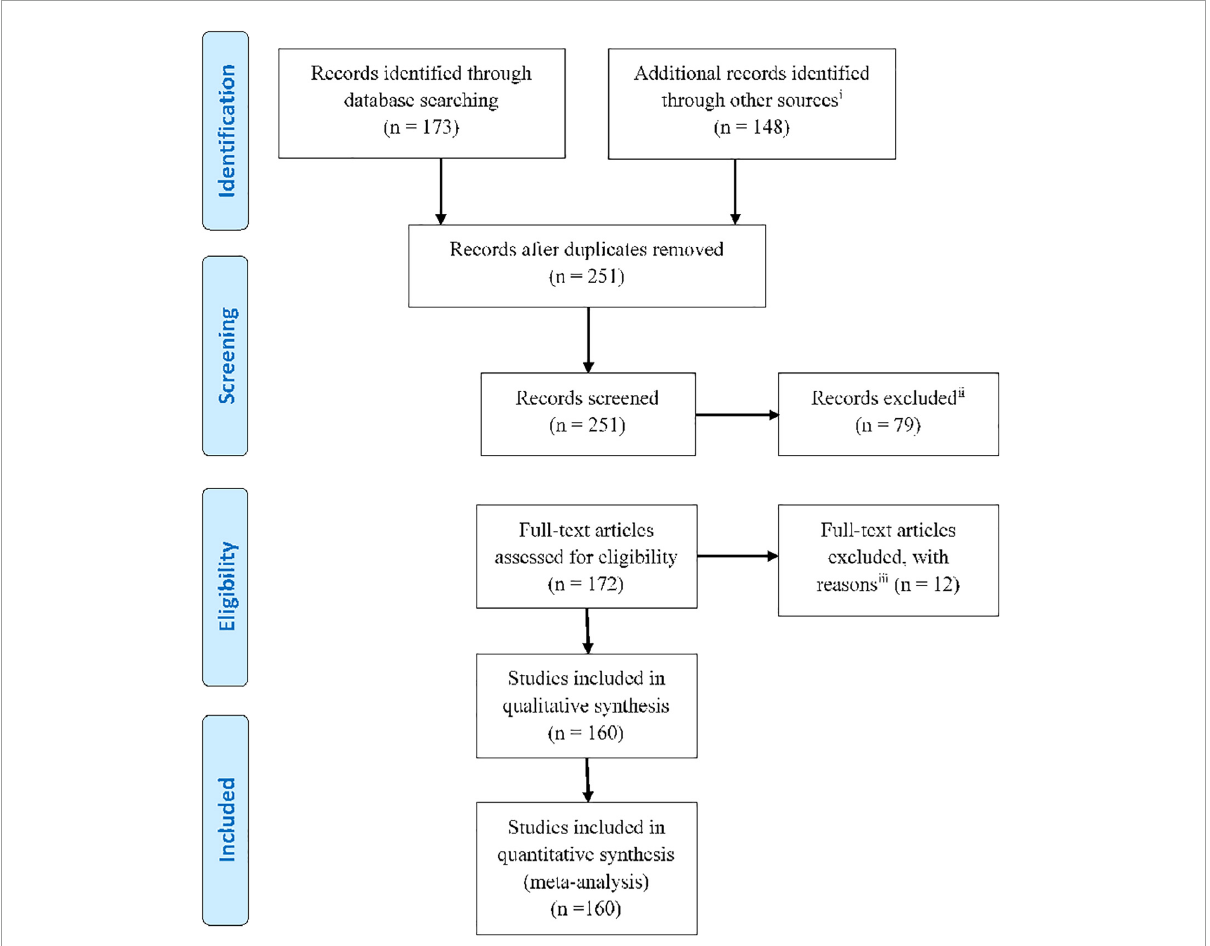
FIGURE1 PRISMA flowchart showing the classification of the extracted articles related to the functional neurological assessment by simultaneous EEG-fMRI